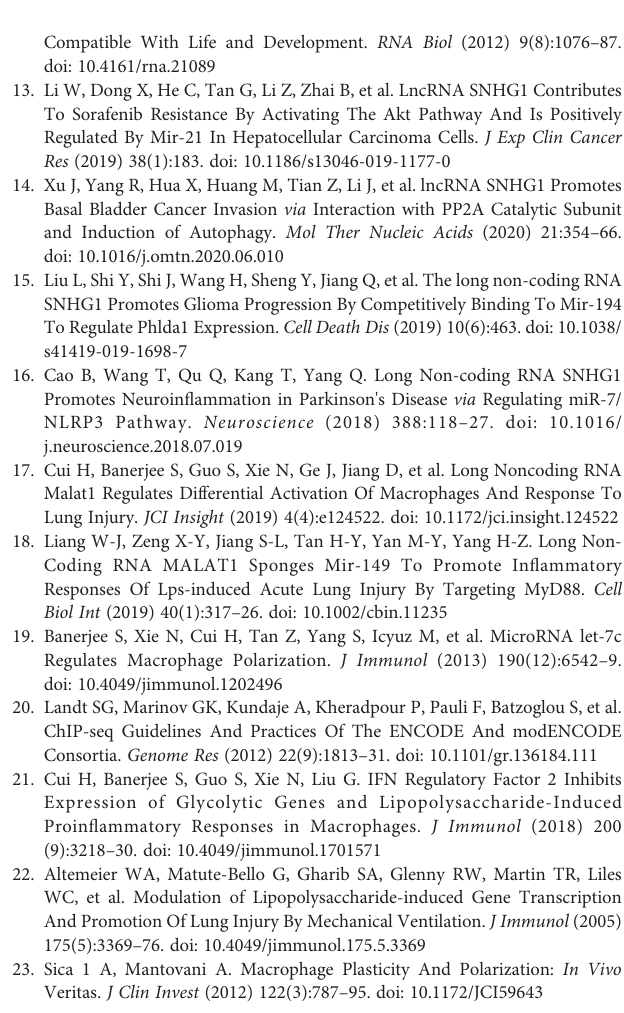
Supplementary Figure 1 | RNA probe enrichment effect of SNHG1 in ChIRP assays. Supplementary Figure 2 | Silencing HMGB1 in RAW264.7 cells. (A) Effect of sh- HMGB1 lentivirus infection. (B, C) The ef fi ciency of HMGB1 in RAW264.7 cells transfected withlentivirus sh-HMGB1-551 and sh-HMGB1-773 was determined by qRT-PCR and Western